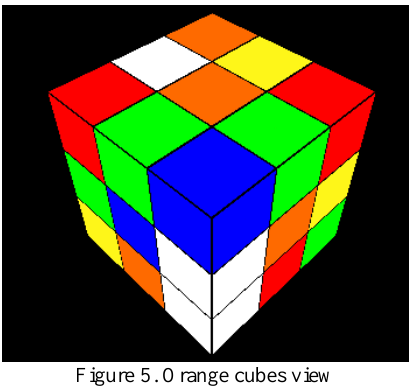
Figure 5. Orange cubes view